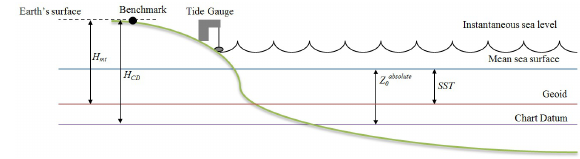
Figure 1. Relationship between the various height types in Eq. (3)